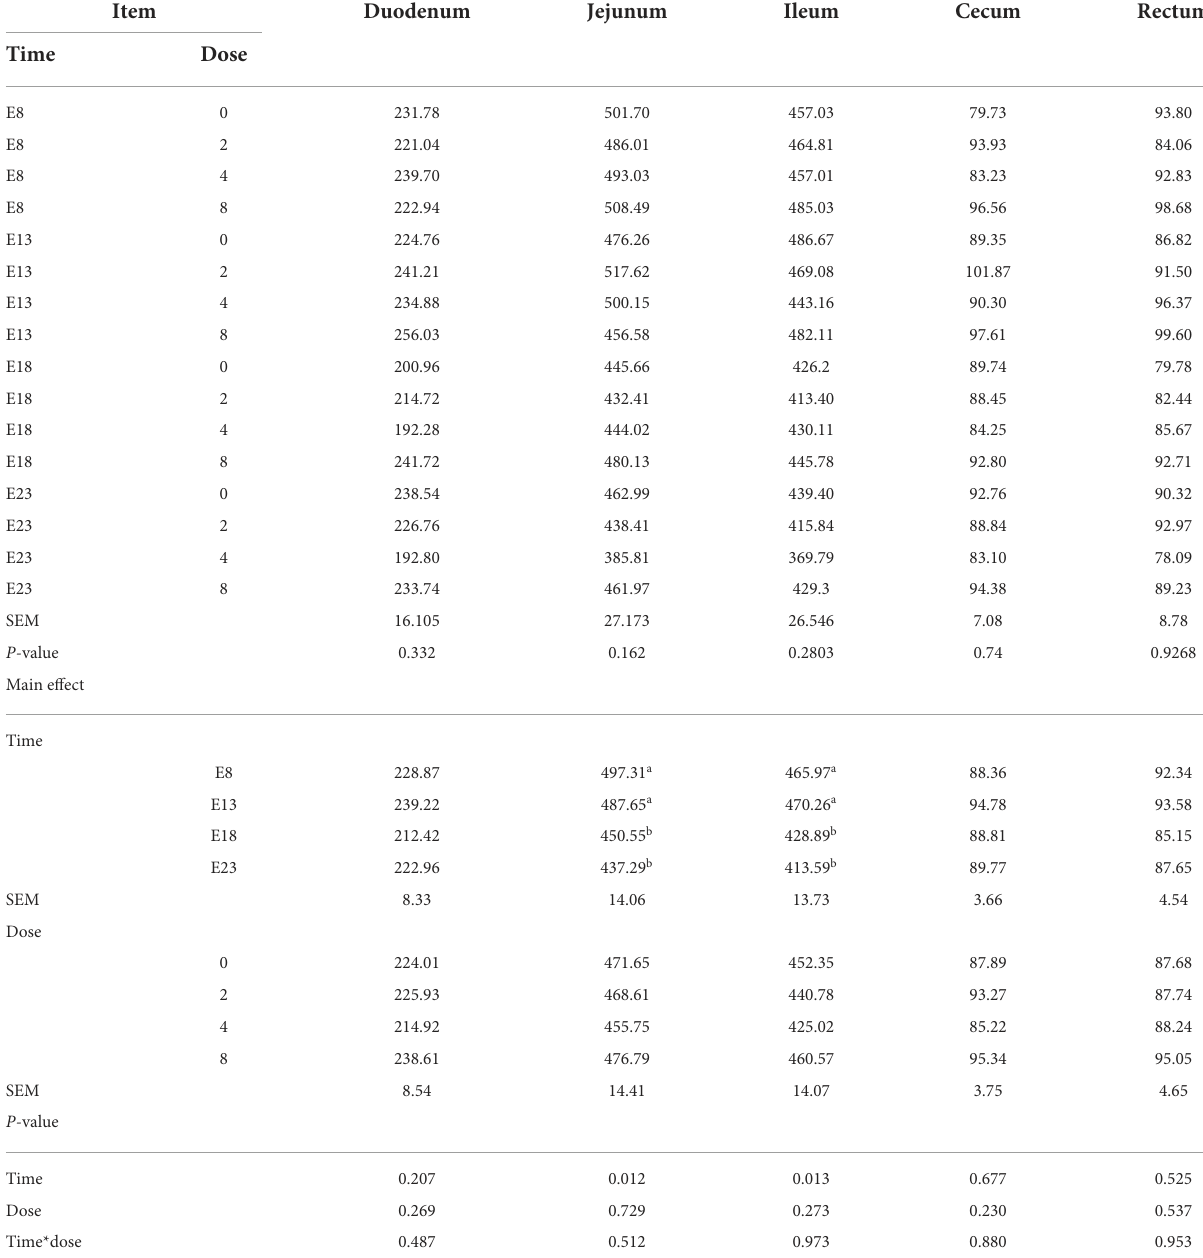
TABLE 3 Effect of time and doses of an embryo injected OTA on the intestinal relative length of ducks at hatching 1 (cm/kg). Item Duodenum Jejunum Ileum Cecum